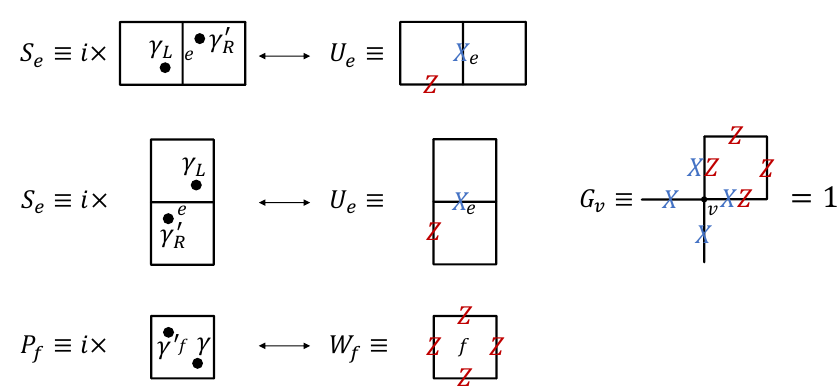
(cid:81) ( i γ ′ γ ) ) symmetry. This is the summary of 2d bosoniza- Figure 8: Gauging (cid:90) f ( = f f 2 f tion on the square lattice. There are two Majorana fermions γ , γ ′ at each vertex f f f on the left-hand side, and a qubit on each edge e on the right-hand side, described by = i γ γ ′ the Pauli matrices X , Y , Z . The Majorana hopping operator S ( L / R is the e e e e L R = i γ ′ γ face left / right to e ) and the on-site fermion parity operator P defined in the f f f figure generate all (cid:90) f symmetric operators. S and P are mapped to Pauli operators e f 2 U and W shown in the figure. Note that the bosonic side is required to satisfy the e f gauge constraint G on each face. The fermionic side requires even fermion parity: v (cid:90) f = 2